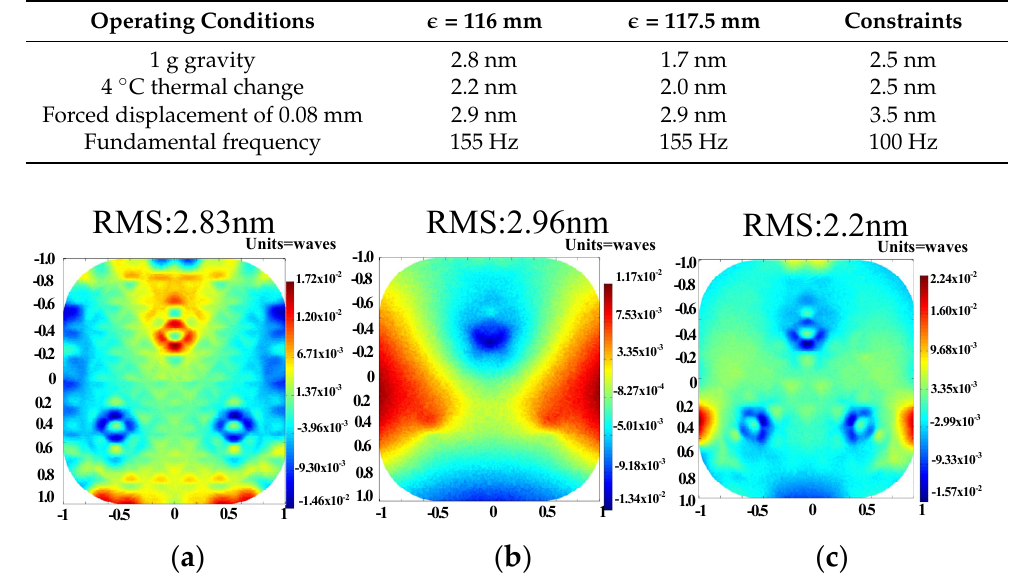
Figure 11. The results show that the surface of the mirror assembly under different working conditions when (cid:0) = 116. ( a ) 1 g gravity, ( b ) 0.08 mm forced displacement, and ( c ) 4 °C temperature.